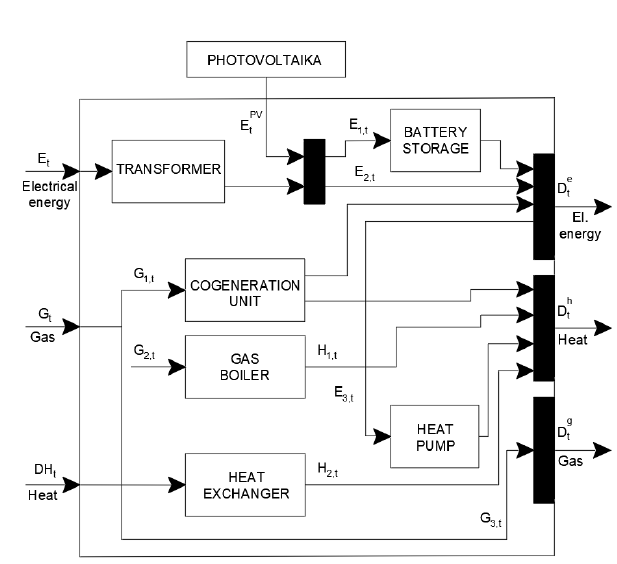
Figure 15. Mathematical Model of EnergyHub.